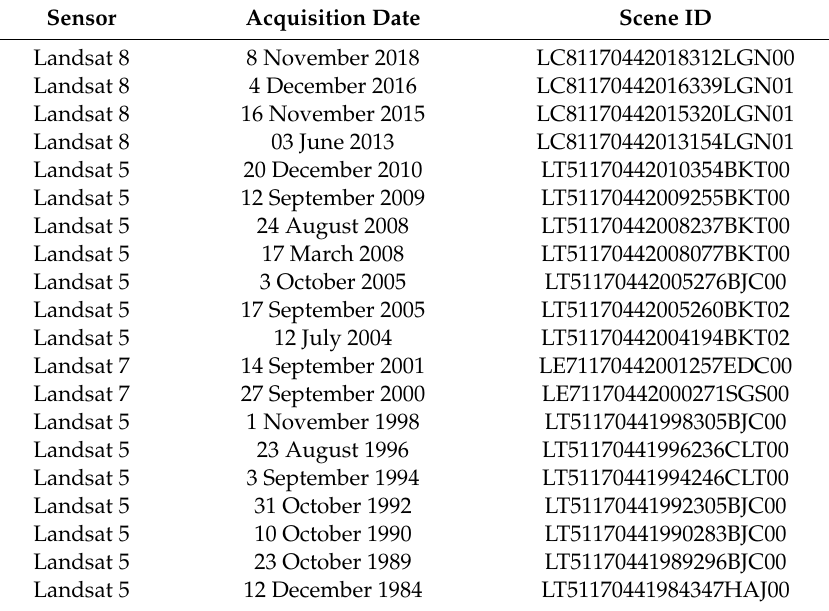
Table 1. Landsat satellite images for the study area.